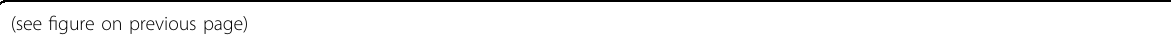
Fig. 6 Functional Characterization of hMSCs. A Transmission electron microscopic observations depicting ultra-structural changes occurring in hMSCs after neuronal induction. (i) Ultra-structural composition of hMSCs has changed on various parameters. There was observed increased mitogenesis, increase in dense core vesicles, rough endoplasmic reticulum, cytoskeletal condensation and endocytotic vesicles. The genesis of these cellular organelles may be associated with the increased functionality of the terminally differentiated hMSCs. (ii) Part of the cell membrane showing the release of vesicles (probably synaptic vesicles) by exocytosis, contributing to the chemical functionality of the DAergic neuronal cells. In this fi gure, # represent rough endoplasmic reticulum, * represent mitochondria, represent endocytotic vacuoles, (cid:129) represent cytoskeletal condensation and represent dense core vesicles. å represent the exocytotic vesicles released from differentiated DP-MSCs. B Calcium ion imaging analysis by Fura red-AM ratiometric dye: (i) line graphs showing the changes in the Ca 2 + transients upon depolarization with KCl in cells of all study groups. The uninduced hMSC did not show any change in the intracellular Ca 2 + concentration after depolarization. The red arrows indicate the time point of addition of KCl for depolarization in the cell culture; (ii) graph showing the change in the percentage increase in the calcium ion concentration in hMSCs obtained from various tissue sources after DAergic neuronal induction by 22-HC. Data points represent the means±SD ( n = 5), * p <0.001 vs. control untreated cells. C qRT-PCR transcriptional analysis of liver X receptors α and β , which are the main nuclear receptors, reported to date, responsible for DAergic neurogenesis by oxysterols (22-HC). Our results suggest a prominent role of LXR β in DAergic neurogenesis with 22-HC as inducer DP-MSC only.